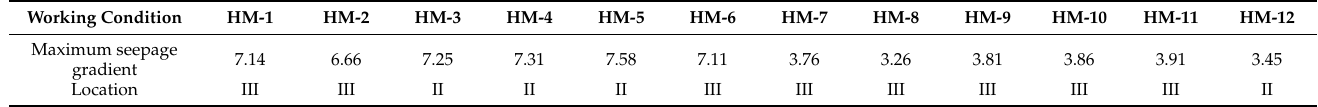
Table 5. Maximum average seepage gradient of the Hami concrete-face rockfill dam’s grouting curtain.